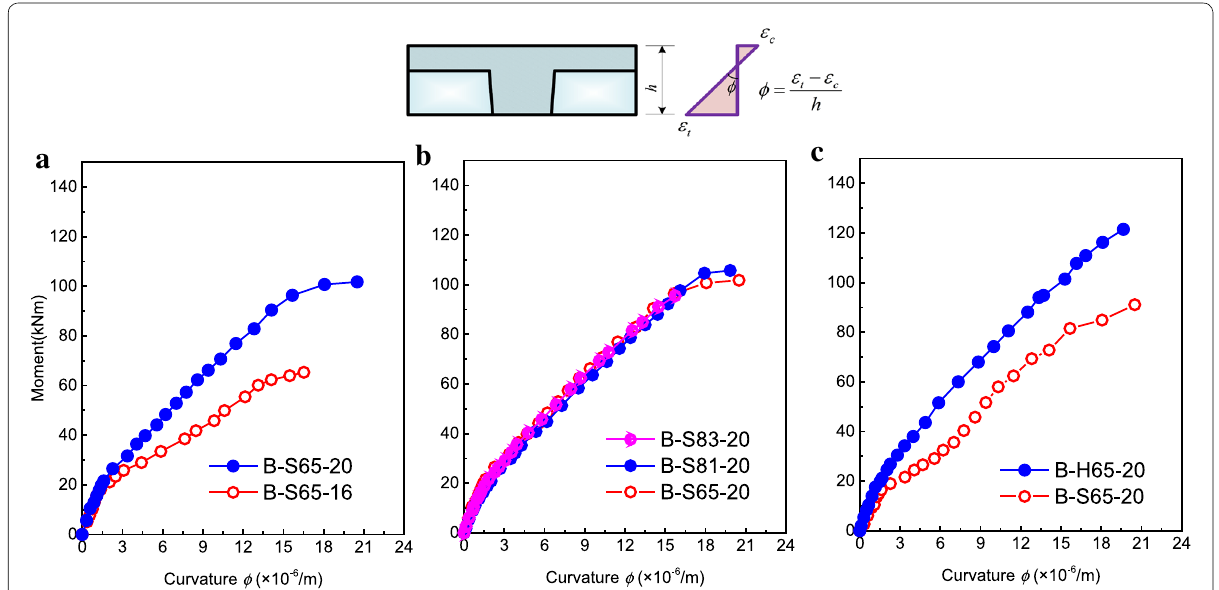
Fig. 14 Bending moment–curvature curves of the specimens: ( a ) different reinforcement ratios; ( b ) different fiber lengths; ( c ) different fiber shapes.